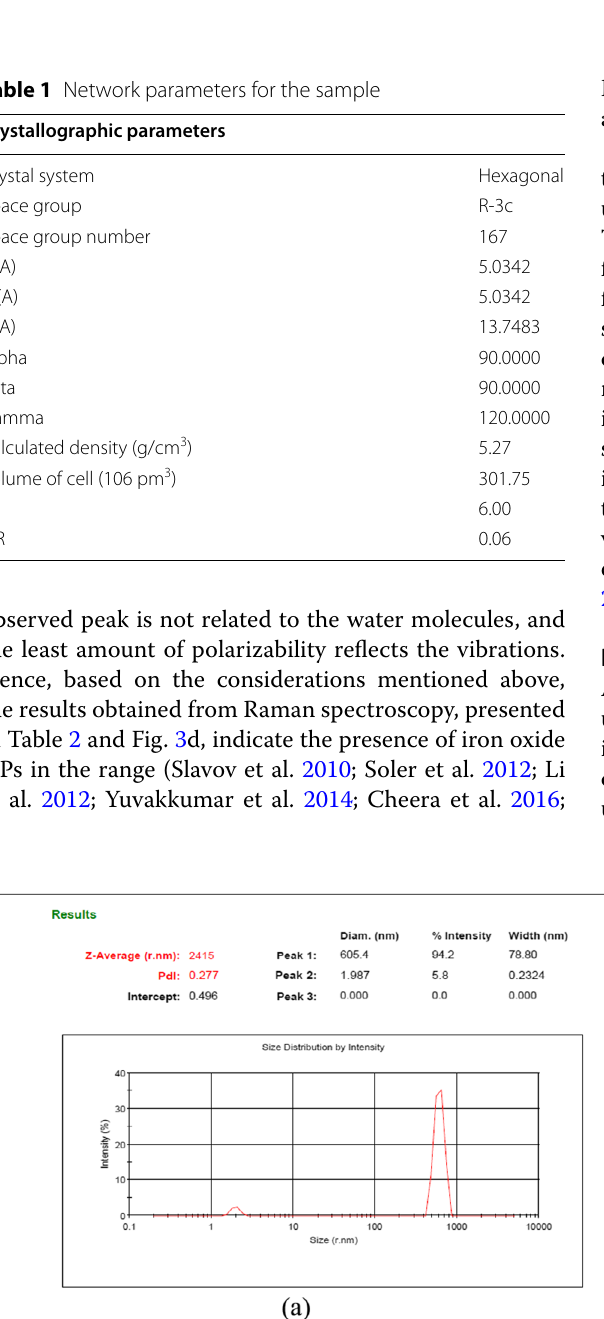
Fig. 4 a Size distribution graph for the iron oxide nanoparticles, b Zeta potential diagram and the charge distribution of iron oxide particles